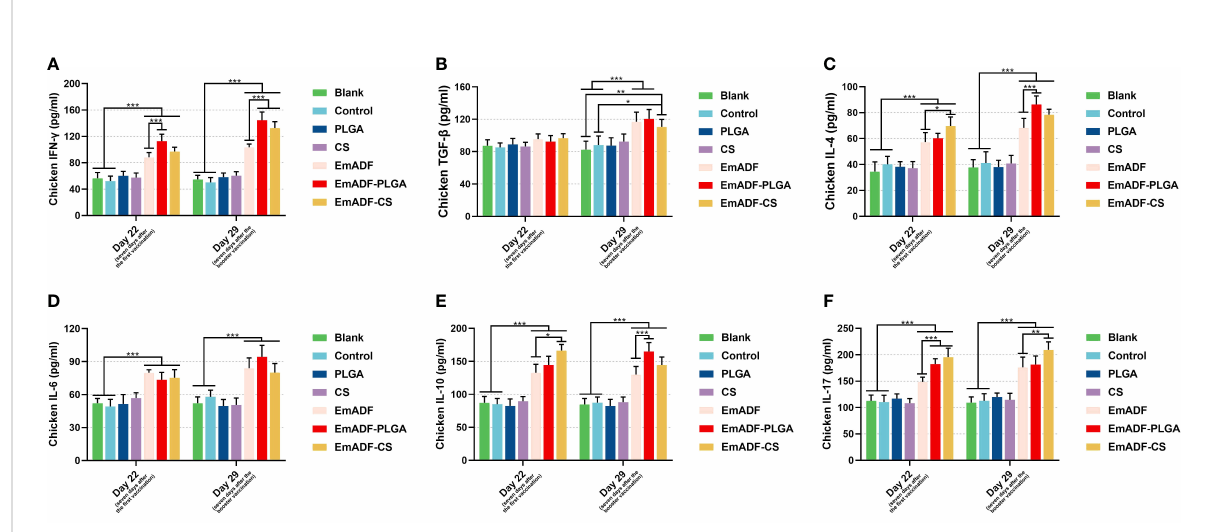
FIGURE 6 Determination of cytokines in chickens ’ sera. The concentrations of IFN- g (A) , TGF- b (B) , IL-4 (C) , IL-6 (D) , IL-10 (E) , and IL-17 (F) were illustrated by commercial ELISA kits. Each group involved fi ve biological replicates, and each replication was detected once. Values were estimated using one-way ANOVA analysis followed by Dunnett ’ s test. Comparisons among EmADF, EmADF-PLGA, and EmADF-CS group were conducted by ANOVA following Bonferroni ’ s correction. Values were presented as the mean of the mean ± SD. * p< 0.05, ** p< 0.01, and *** p<